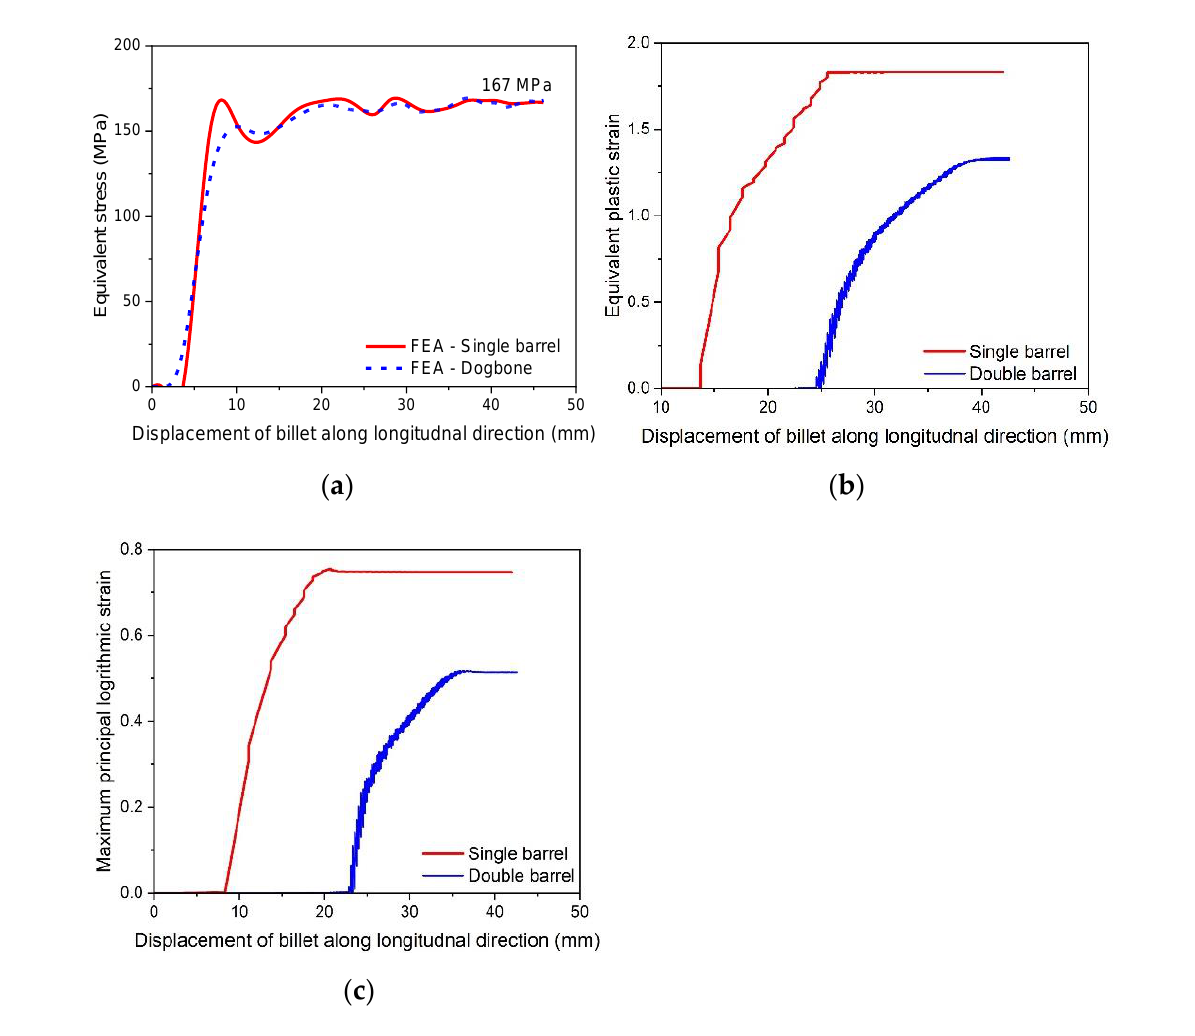
Figure 19. Material deformation parameters for single and double barrels, ( a ) von Mises stress, ( b ) equivalent plastic strain, ( c ) maximum principal logarithmic strain.